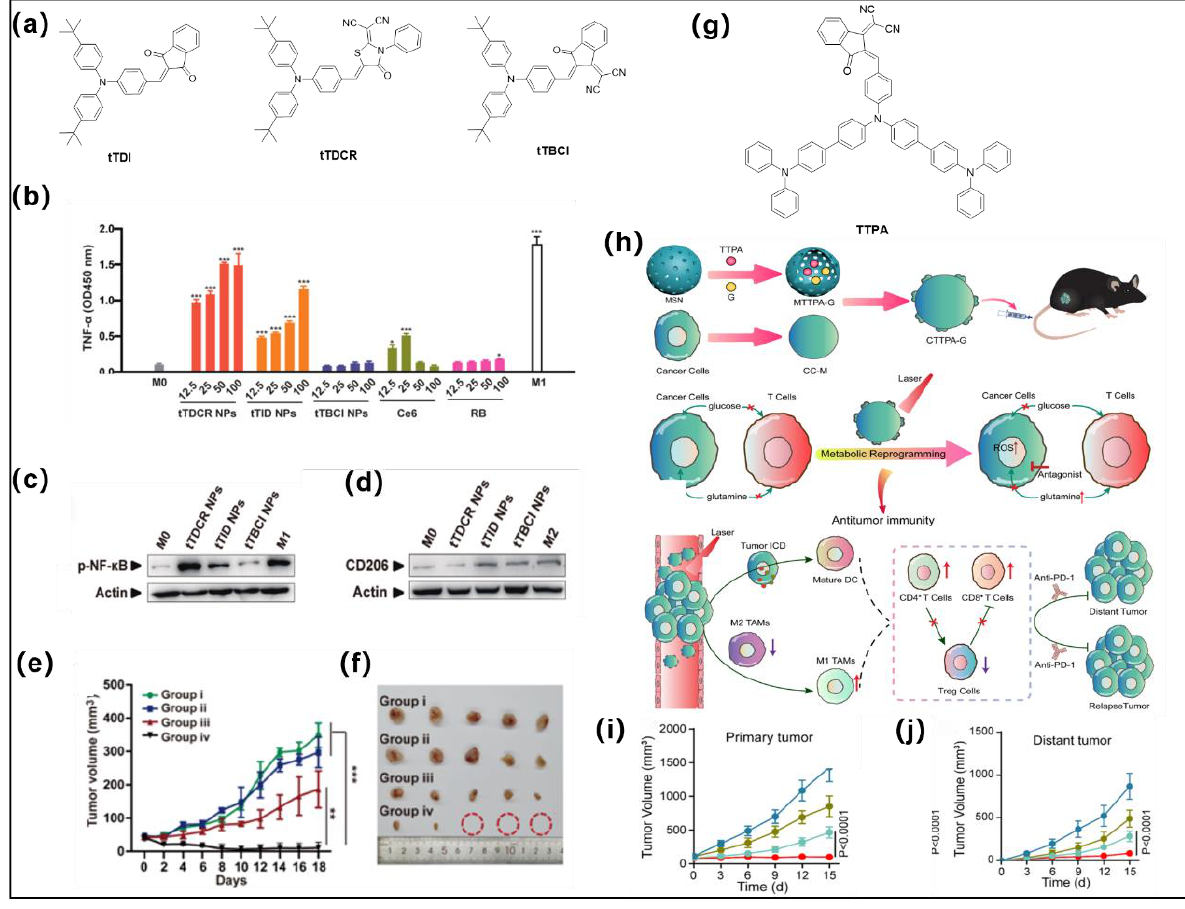
Figure 7. ( a ) Molecular structures of tTDI , tTDCR , and tTBCI . ( b ) The level of TNF- α secreted